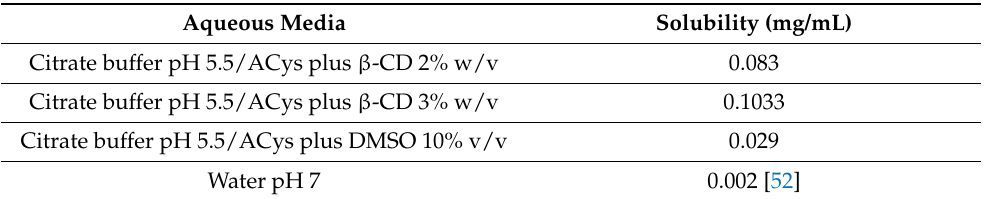
Table 3. QRC solubility (mg/mL) ± SE in various aqueous media at 37 ± 0.5 °C .